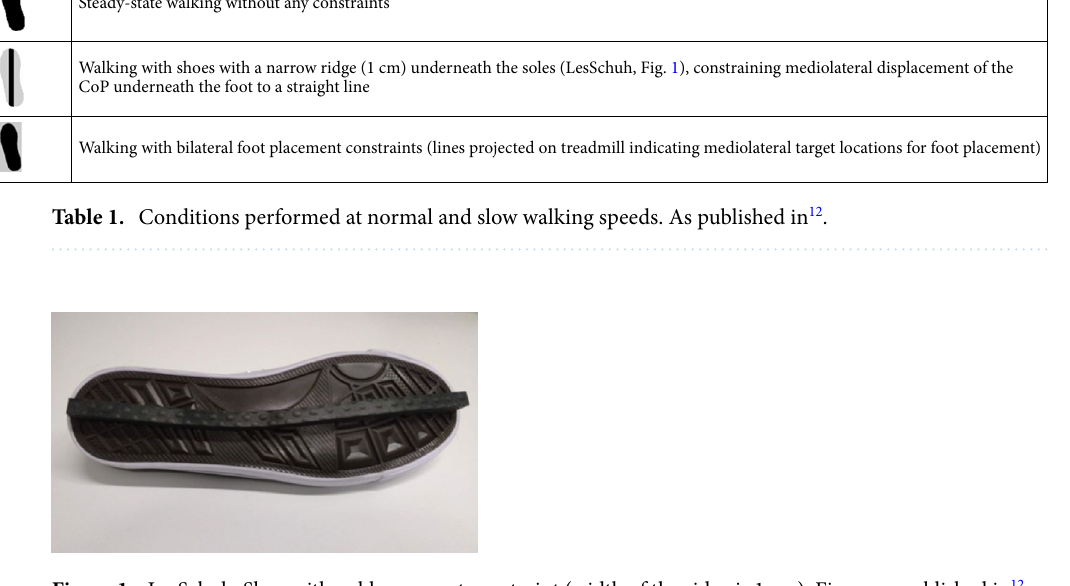
Figure 1. LesSchuh. Shoe with ankle moment constraint (width of the ridge is 1 cm). Figure as published in 12